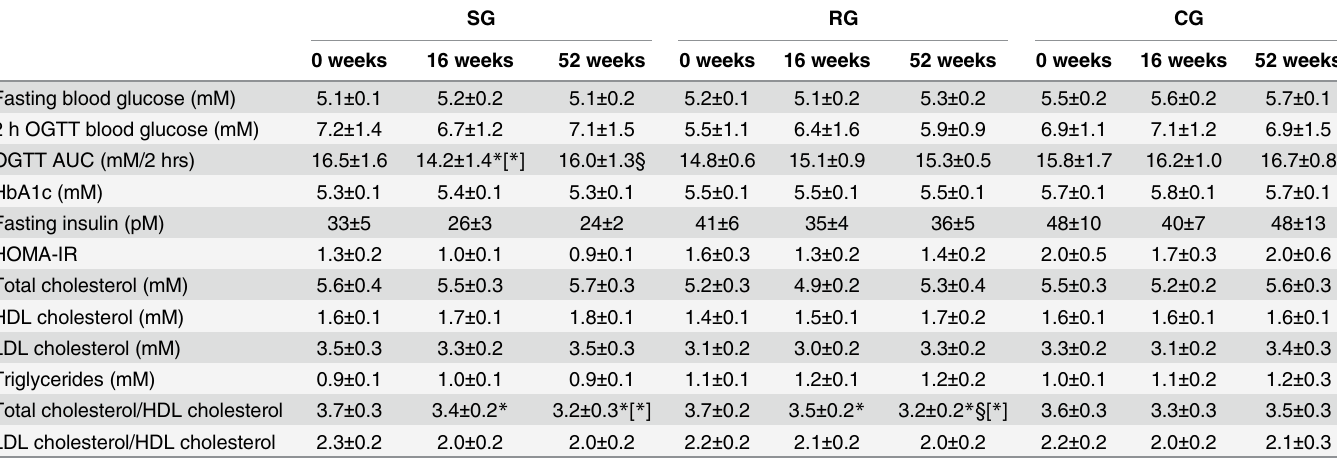
Table 4. Resting blood variables during 52 wks of soccer or resistance training in elderly